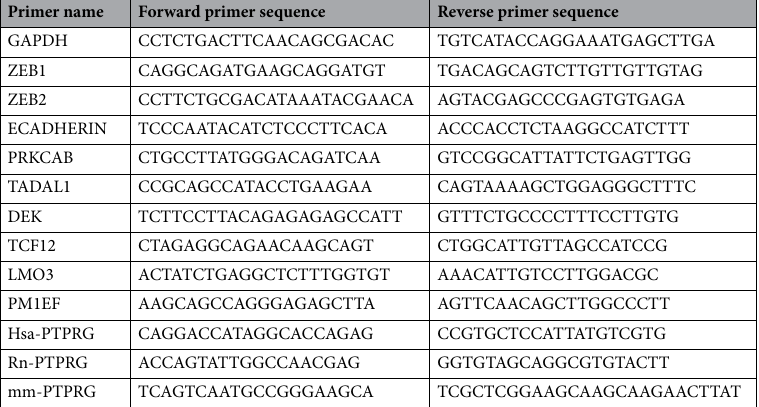
Table 2. Oligonucleotide primer sequences for SYBR Green qPCR.